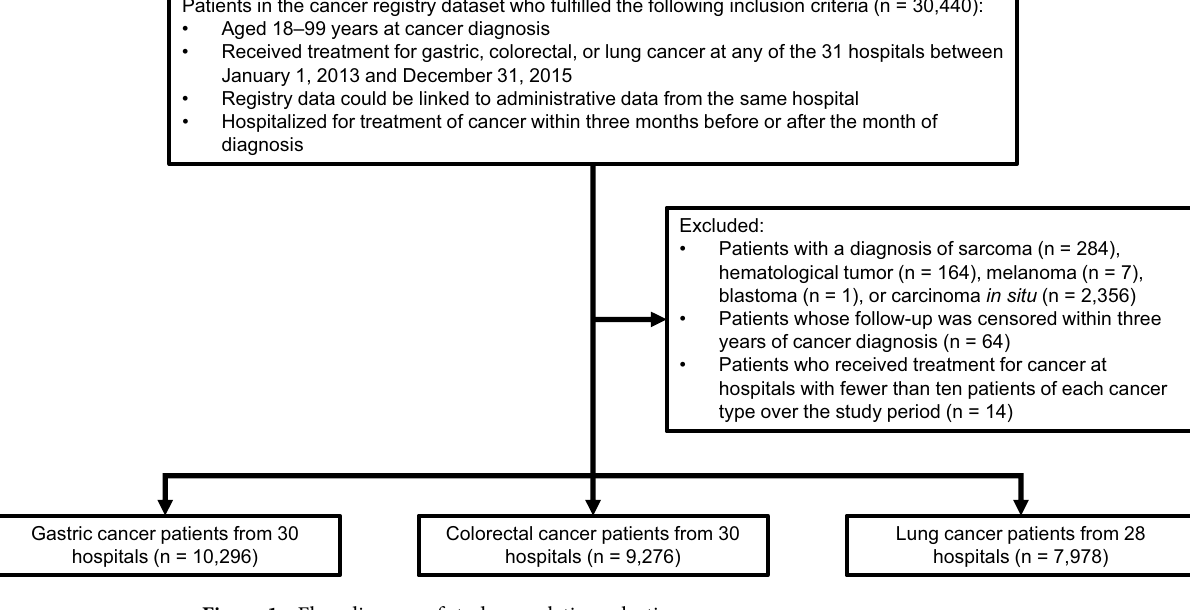
Figure 1. Flow diagram of study population